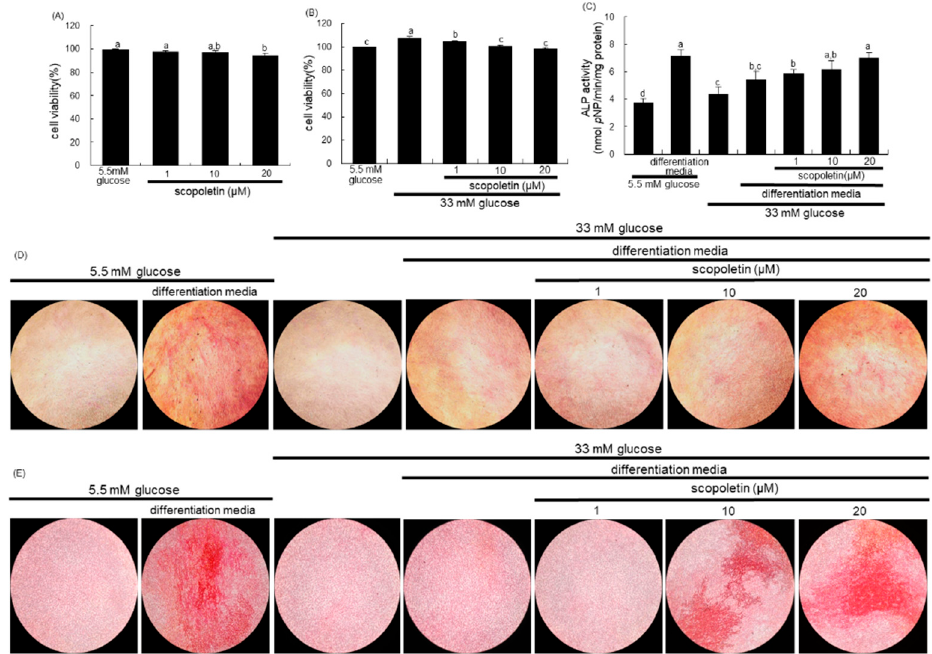
Figure 6. Cell toxicity of scopoletin ( A , B ), and elevation of alkaline phosphatase (ALP) activity ( C , D ) and calcium deposit ( E ) in pre-osteoblastic MC3T3-E1 cells treated with scopoletin. MC3T3-E1 cells were cultured in α -MEM-differentiation media containing 5.5 mM glucose or 33 mM glucose for three days in the absence and presence of 1–20 μ M scopoletin. Cell viability was measured by the MTT assay and expressed as percent cell survival relative to untreated glucose controls ( A , B , cell viability = 100%, mean ± SEM, n = 4). For the measurement of ALP activity ( C ), the MC3T3-E1 cells were cultured in α -MEM-differentiation media containing 5.5 mM glucose or 33 mM glucose in the presence of 1–20 μ M scopoletin for seven days. The ALP enzyme activity in media was expressed as nmol p -nitrophenyl phosphate ( p NP)/min/mg protein. Absorbance was measured at λ = 450 nm and compared with p -nitrophenol standard (mean ± SEM, n = 3). Values in bar graphs not sharing a small letter are different at p < 0.05. The ALP staining was visualized under light microscopy ( D ). The calcium deposit (bone nodule formation) was measured by Alizarin red S staining ( E ). MC3T3-E1 cells were cultured in α -MEM-differentiation media containing 5.5 mM glucose or 33 mM glucose in the presence of 1–20 µ M scopoletin for 21 days. Microphotographs were representative of 21 day-grown osteoblasts on the well slides. The calcium deposits were visualized under light microscopy. Magnification: